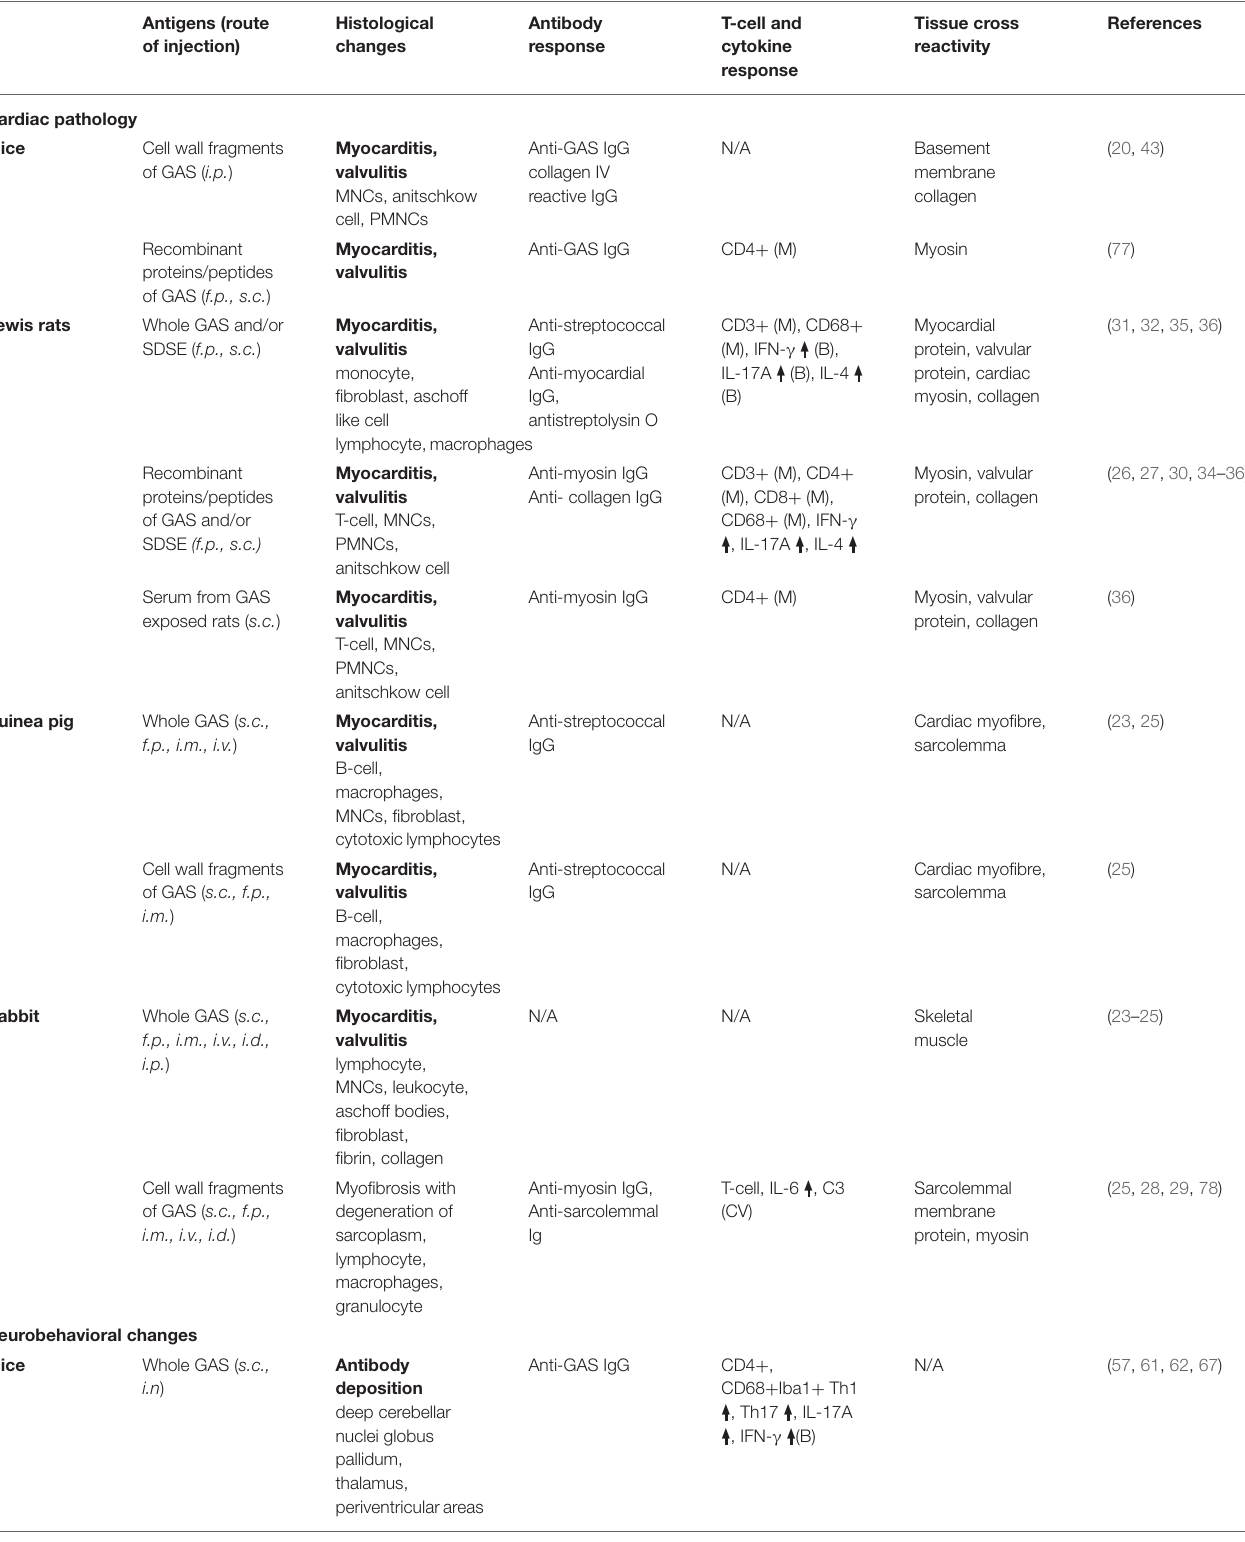
TABLE 1 | Immunopathological changes in small animals and rodents investigated as experimental model for post streptococcal